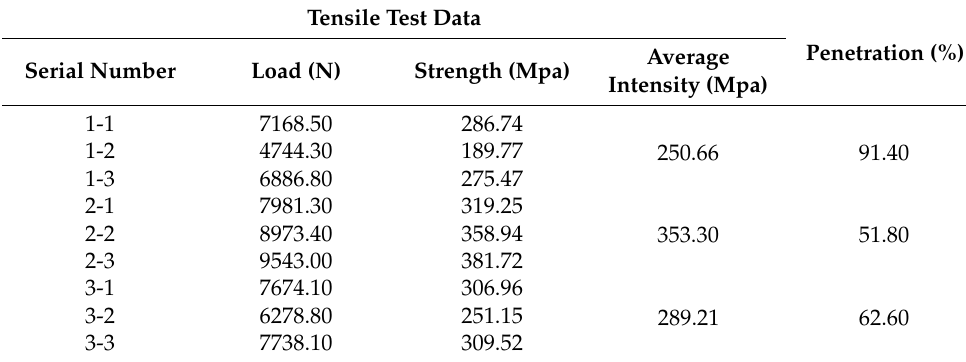
Table 4. Tensile test data and penetration